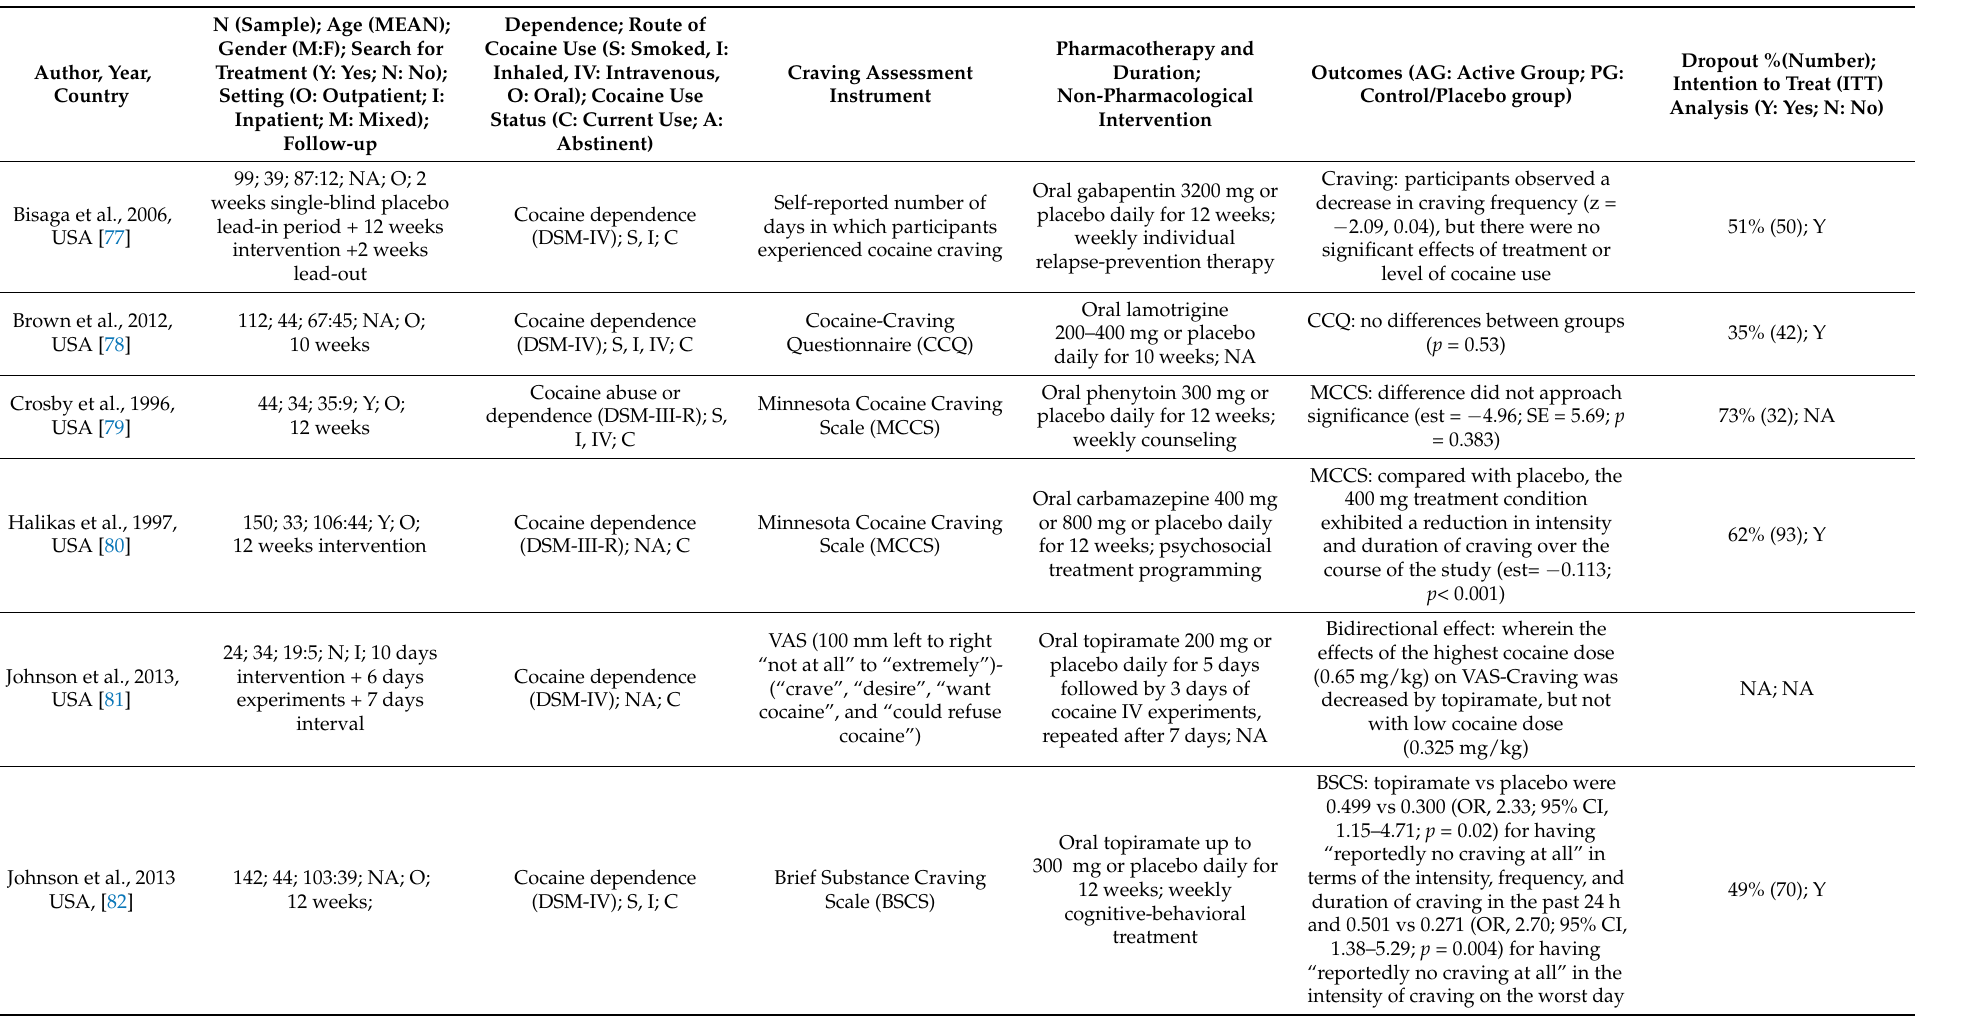
Table 4. Characteristics and main findings of the studies included in the systematic